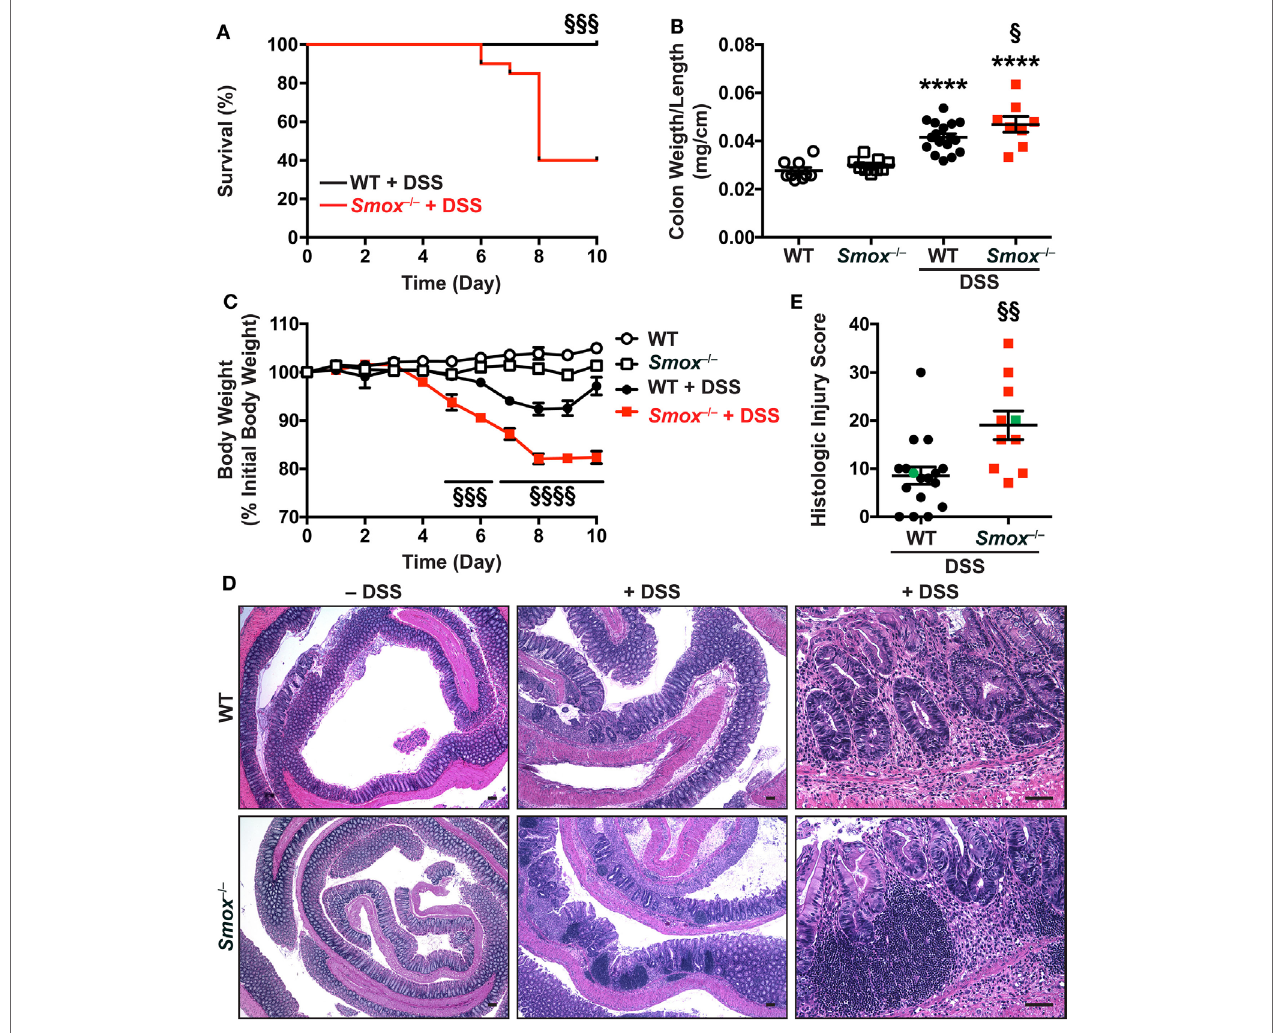
FigUre 2 | Dextran sulfate sodium (DSS) colitis in C57BL/6 mice and Smox − / − mice. Animals were treated with 2.5% DSS for 5 days and then kept for 5 more days. (a) Survival was monitored daily; the Kaplan–Meier plot was performed from two separate experiments [ n = 18 wild­type (WT) and n = 20 Smox − / − mice]. (B) Colons were harvested, measured, washed, and weighed. (c) Body weights of all the animals in panel (a) were measured daily and are presented as percentage of initial body weight. (D,e) Colons were Swiss­rolled and stained with hematoxylin and eosin (D) and scored for histologic injury (e) . The histologic injury score of untreated WT and Smox − / − mice was 0 for both. In panel (e) , the green points represent the animals depicted in panel (D) . Scale bar, 50 µm. In all panels, **** P < 0.0001 compared with uninfected animals; § P < 0.05, §§ P < 0.01, §§§ P < 0.001, and §§§§ P < 0.0001 versus DSS­treated WT